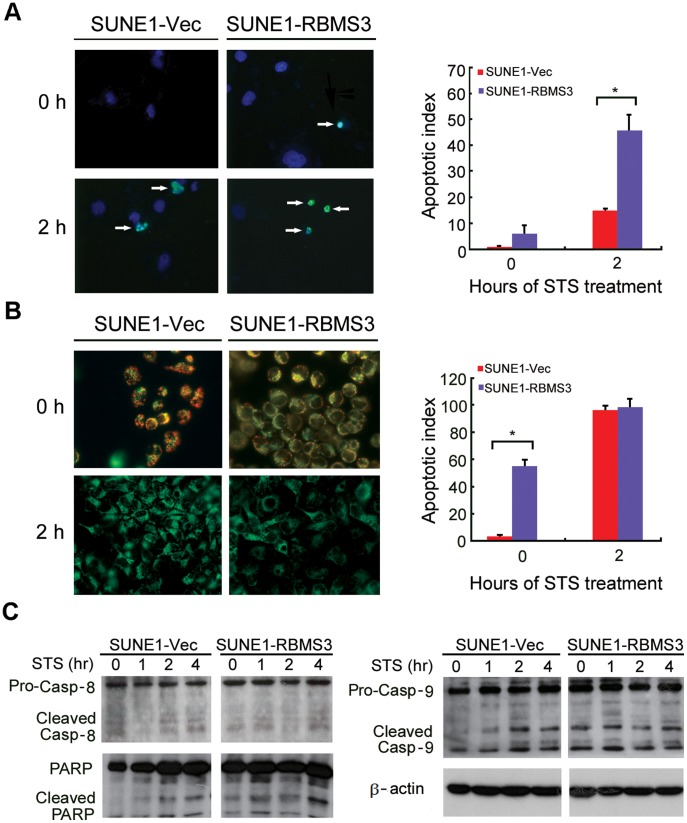
Ectopic expression of RBMS3 induces apoptosis.(A) Representative images of TUNEL staining. After STS treatment, more apoptotic cells (green) were detected in SUNE1-RBMS3 cells compared to SUNE1-V1 cells (arrowhead). The apoptotic indexes of SUNE1-RBMS3 cells and SUNE1-V1 cells (before and after STS treatment) were summarized in the right panel (*p<0.05). (B) This event was measured by loss of mitochondrial ΔΨm using JC-1 dye. Red or orange fluorescence indicates intact mitochondria, whereas green fluorescence indicated a collapse in mitochondrial ΔΨm. Prior to STS treatment the SUNE1-RBMS3 cells reveal a significant ΔΨm loss (green fluorescence, ×400) and higher apoptotic index compared to SUNE1-V1 cells (red/orange fluorescence; left panel) (*p<0.05). (C) The cleavages of caspase-9, caspase-8, and PARP were compared between RBMS3-transfected and empty vector-transfected SUNE1 cells. β-actin was used as loading control.